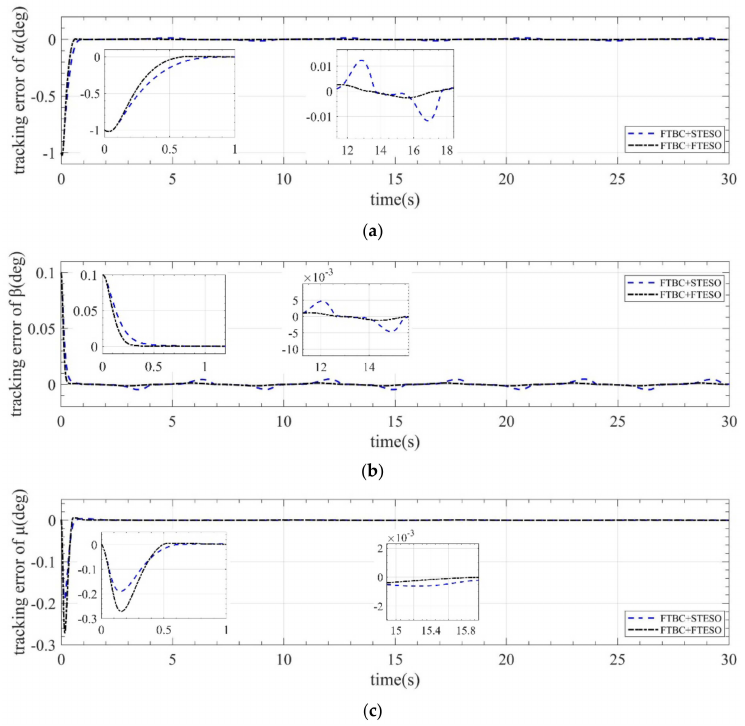
Figure 4. ( a ) Tracking error curve of e α , ( b ) tracking error curve of e β , and ( c ) tracking error curve of e µ .